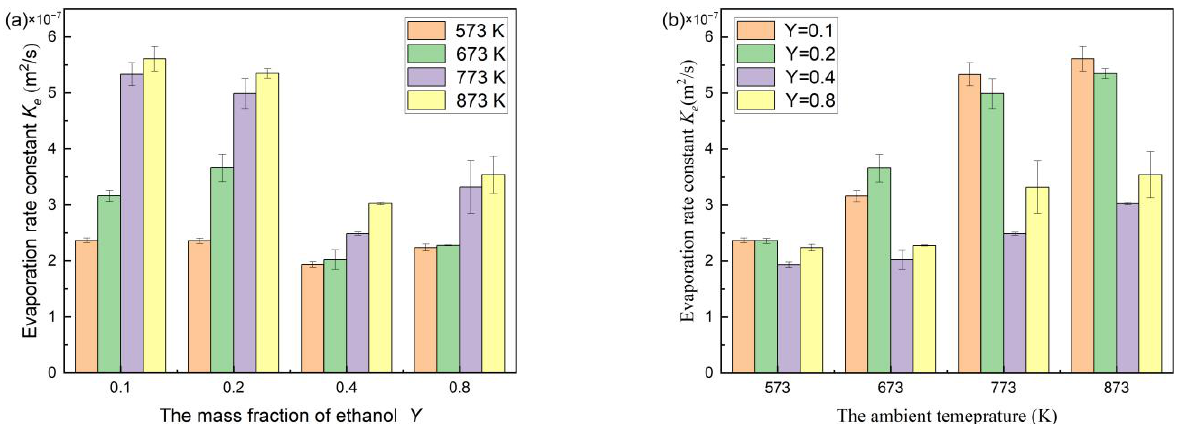
Figure 7. Evaporation rate constants of n-decane/ethanol bi-component droplets: ( a ) at different mass fractions of ethanol at certain a temperature, ( b ) in the ambient hot air of different temperatures at certain a mass fraction. Table 3. Experimental and numerical simulation results of different mass fractions of ethanol-n- decane droplet evaporation in different gas temperatures.